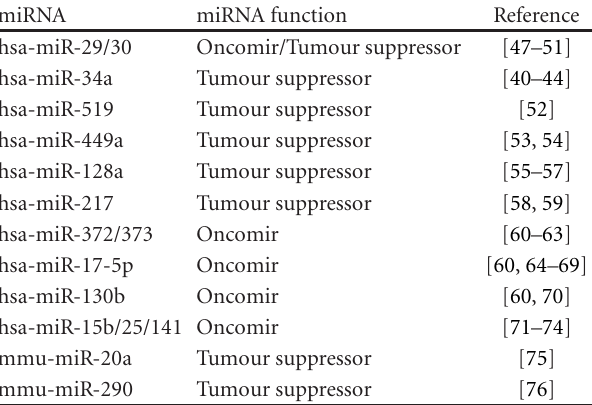
Table 1: Novel miRNAs involved in